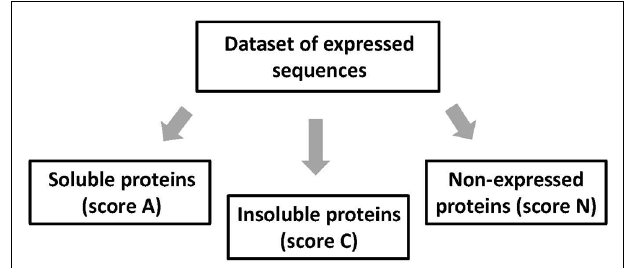
FIGURE 2 | Categorical evaluation of protein expression data. At this stage, all expressed sequences are categorized into the three mutually exclusive categories – soluble (A), insoluble (C), and non-expressed (N) proteins.